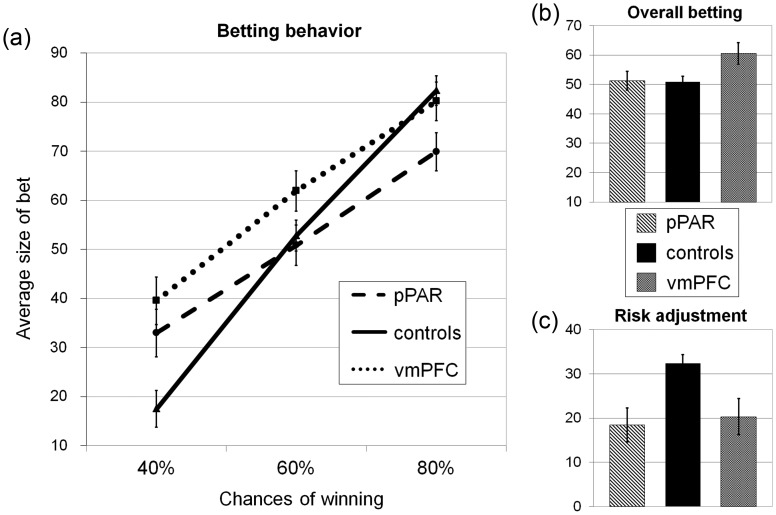
Betting behavior. (a) Average bet size in 40%, 60%, and 80% trials for each of the 3 experimental groups. Compared with healthy controls, pPAR lesion patients adjusted their bets less to the chances of winning, choosing larger bets at low chances of winning and smaller bets at high chances of winning. vmPFC lesion patients selected higher bets than healthy controls overall, and particularly at low chances of winning. (b) Overall betting behavior collapsed across the 3 chances of winning in the 3 groups: vmPFC lesion patients selected higher bets overall than healthy controls (P = 0.02) and pPAR lesion patients (P < 0.05). (c) Risk adjustment scores in the 3 groups: Decreased risk adjustment scores were observed in both patient groups compared with healthy control subjects (P < 0.01). Error bars represent SEM.